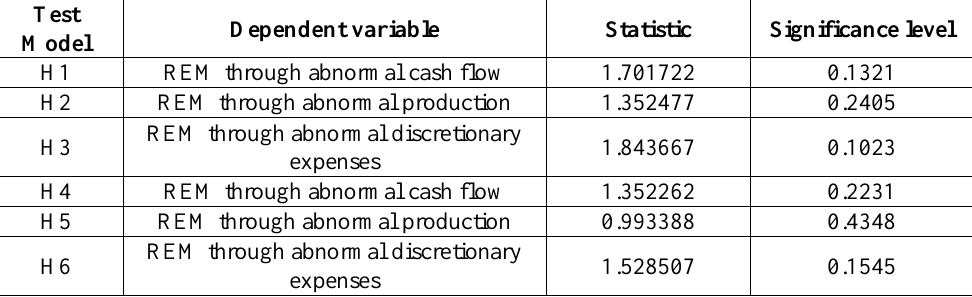
Table 5. heteroscedasticity/ homoscedasticity test for error terms